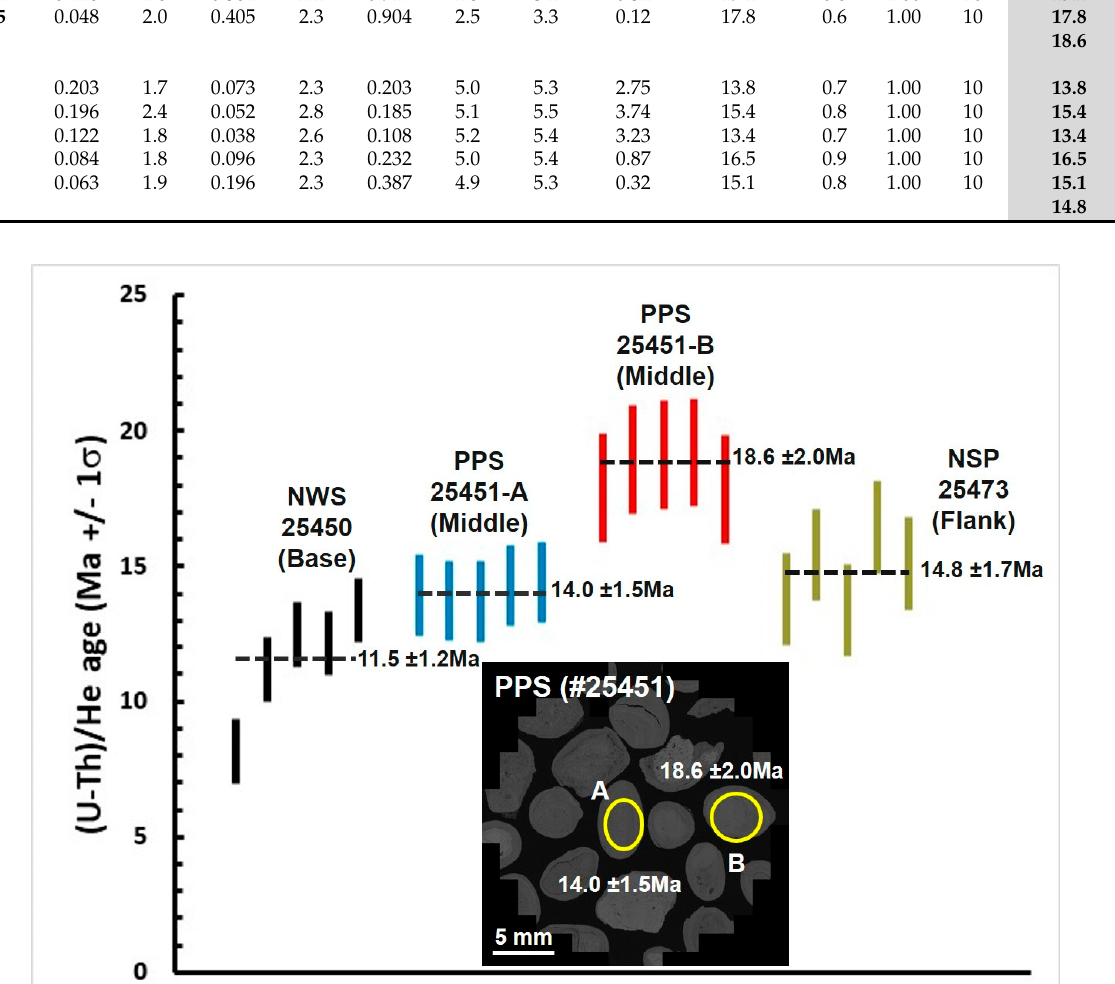
Figure 21. Ranked order plot of (U–Th)/He-dates (Ma) for the measured ferruginous nodules and pisoliths. Each coloured bar represents an individual replicate measurement with the bar ‘size’ (height) defining the associated error of measurement (±1 σ ). The black dashed horizontal line and the adjacent number denote the average age (Ma ± 1 σ ) for the ferruginous nodules.